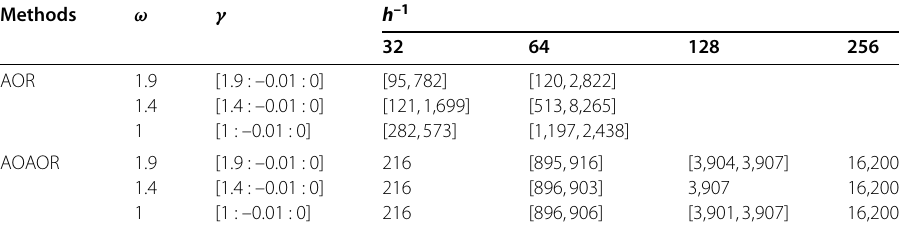
Table 6 The gap of IT when ξ = ζ = σ = 0.0 ( ε = h 2 /5) Methods